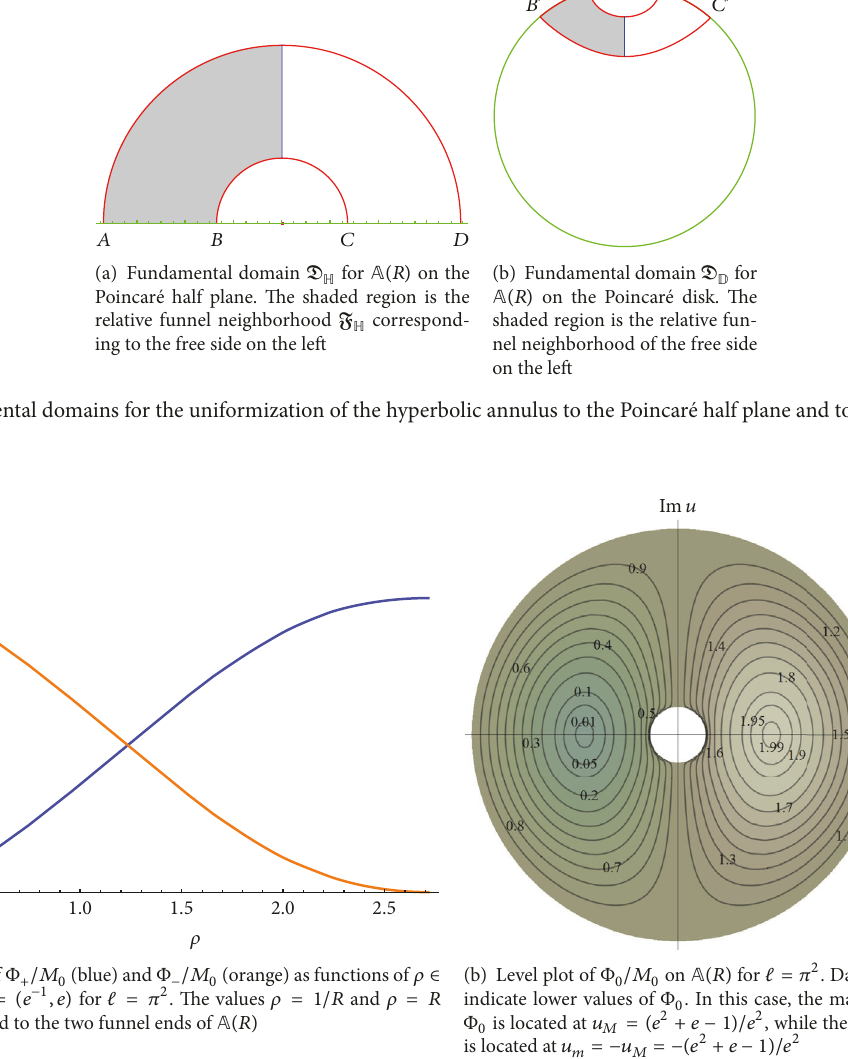
Φ + tends to its infimum at the inner funnel end, while −